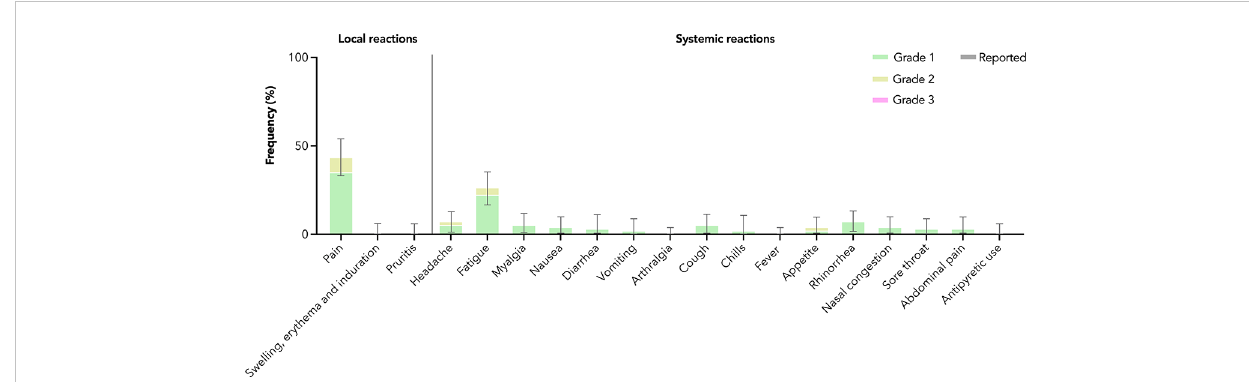
FIGURE 4 Adverse reactions in adolescents after the third dose of CoronaVac. Adverse reactions were reported by maximal severity (grade 1 – green, grade 2 – yellow, grade 3 – pink) within 7 days after vaccination. Antipyretic use was also captured (reported – grey). 95% con fi dence intervals are derived from the Clopper-Pearson method and marked by error bars.